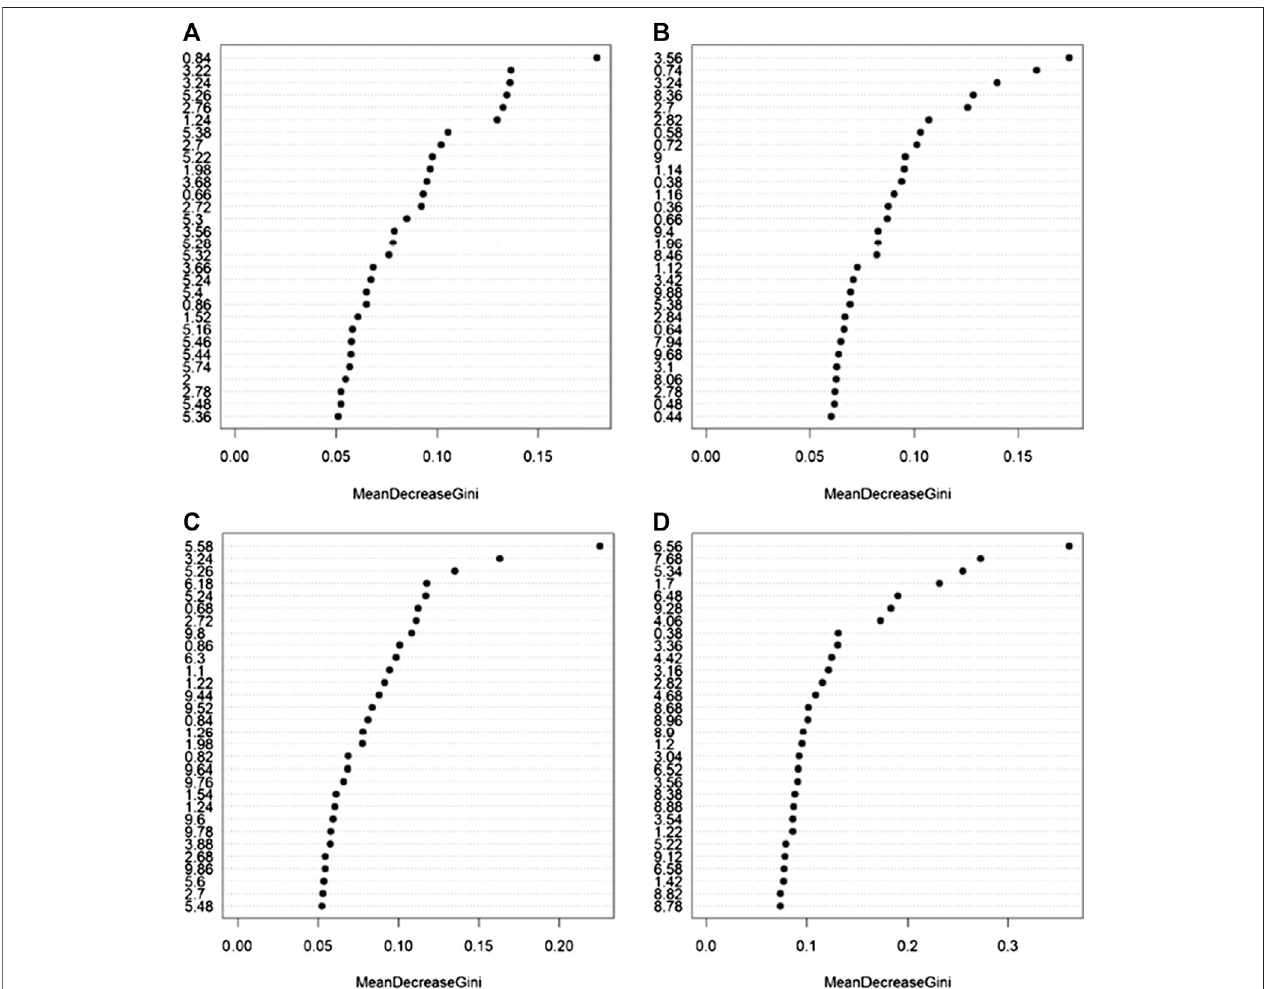
FIGURE3| Binsthatmainlycontributetothediscriminationbetweenpatientswitherectiledysfunctioninducedbyorganiccausesandthoseforwhomthedisease wasrelatedbyothercausescalculatedontheNMRspectraacquired: (A) serumNOESY; (B) serumCPMG; (C) serumDIFFUSION; (D) urineNOESY.Theimportanceis measured by the Gini